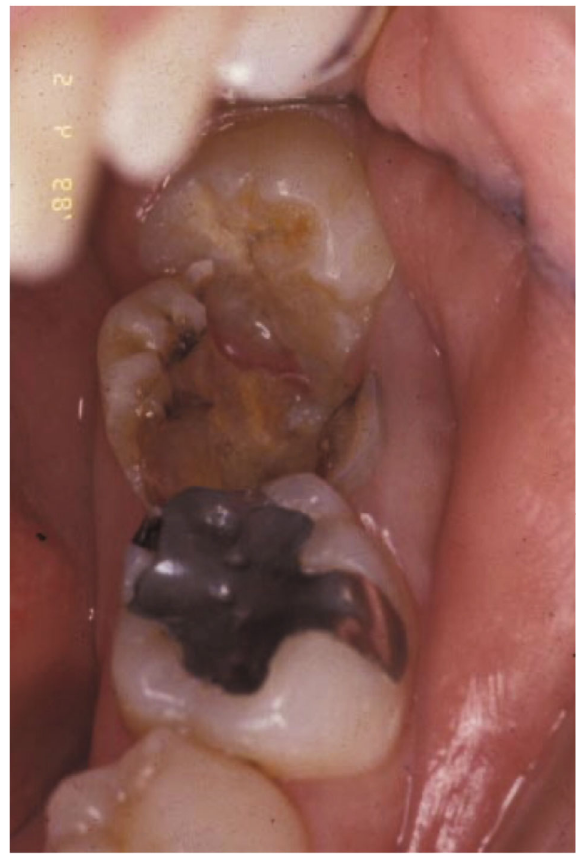
Figure 2: Periapical radiograph at the initial appointment. Large periapical radiolucency was present on the second molar. The gross caries reached to the almost alveolar bone level on the radiograph. This was deemed as a nonrestorable